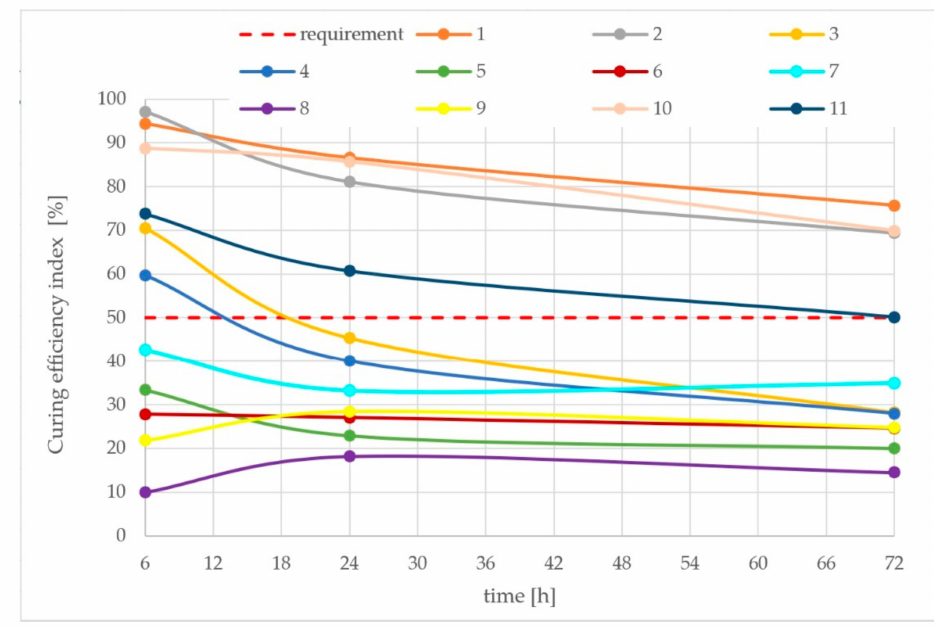
Figure 6. Curing efficiency index for all examined curing compounds samples during 72 h.